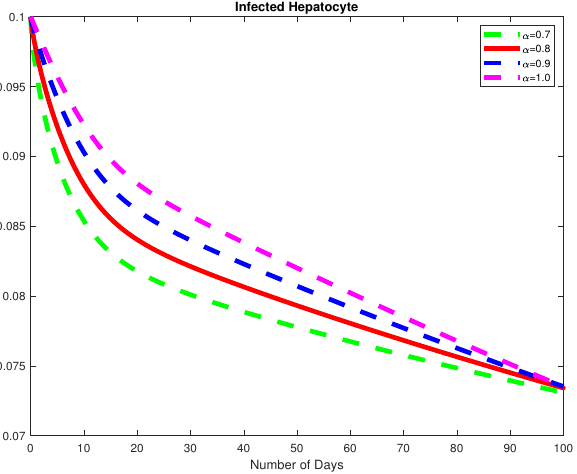
Figure 7. The dynamics of the infected hepatocytes, I , for varying fractional order α .